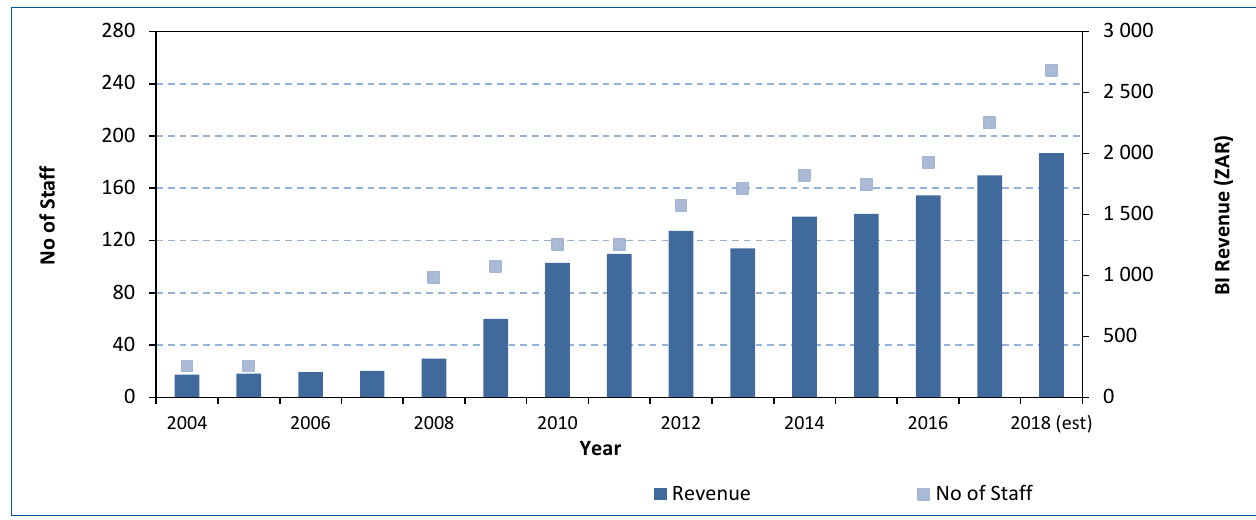
Figure 2. Growth of the Biovac Institute (2004 to 2018)